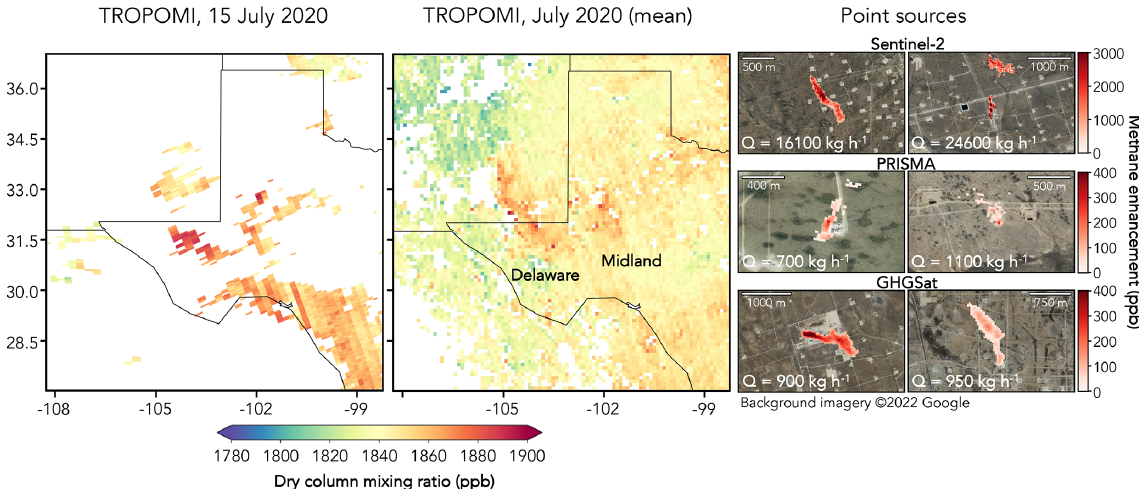
Figure 3. Satellite observations of atmospheric methane over the Permian Basin (Texas and New Mexico) in July 2020. The left panel shows typical TROPOMI observations for 1d (July 15), featuring large areas of missing data where the retrieval was not successful because of cloud cover or other factors. The middle panel shows monthly mean TROPOMI observations on a 0 . 1 ◦ × 0 . 1 ◦ grid, featuring enhancements over the Delaware and Midland basins where oil production is concentrated. TROPOMI data are from the version 2.02 retrieval of Lorente et al. (2021a). The right panel shows sample observations of plumes from point sources by Sentinel-2, PRISMA, and GHGSat superimposed on surface imagery from © Google Earth. Plume dimensions and inferred point source rates ( Q ) are given as an inset. See Sect. 4.2 for the inference of point source rates from plume observations.